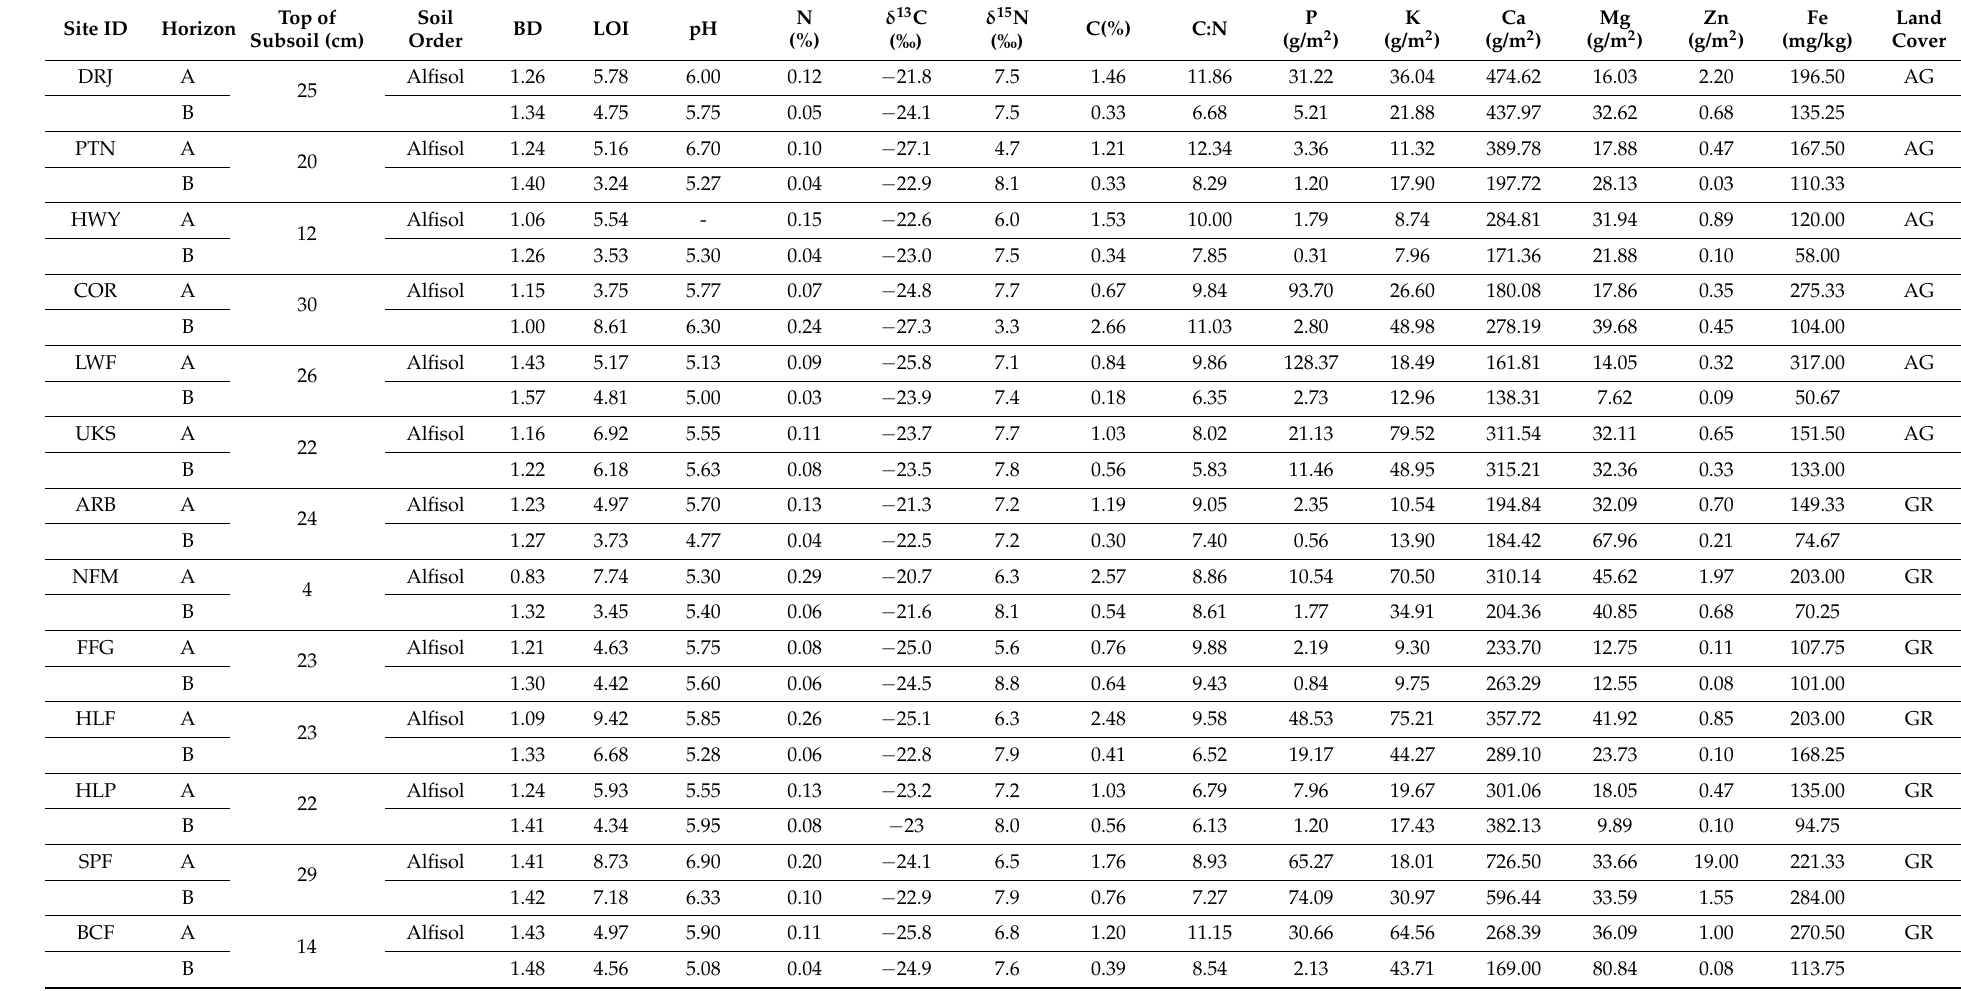
Table 2. Summary of the soil chemical and physical properties for the study sites. Values are shown as the average for the A and B soil horizons. GR = grasslands, FR = forest, AG = agriculture. Site